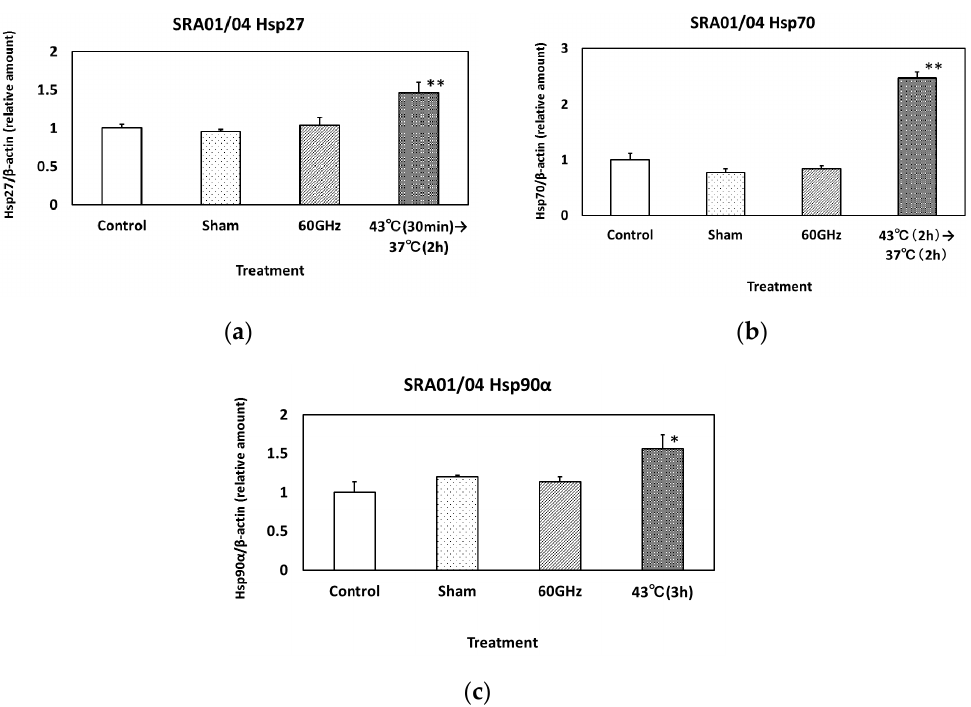
Figure 5. The expression of Hsp27 ( a ); Hsp70 ( b ) and Hsp90 α ( c ) in SRA01/04 cells exposed to 60 GHz radiation for 24 h. The positive control underwent heat treatment at 43 °C for 30 min (Hsp27), 2 h (Hsp70) and 3 h (Hsp90 α ). Data are presented as the mean ± SD from three independent experiments. Asterisks * and ** indicate p < 0.05, and 0.01, respectively.